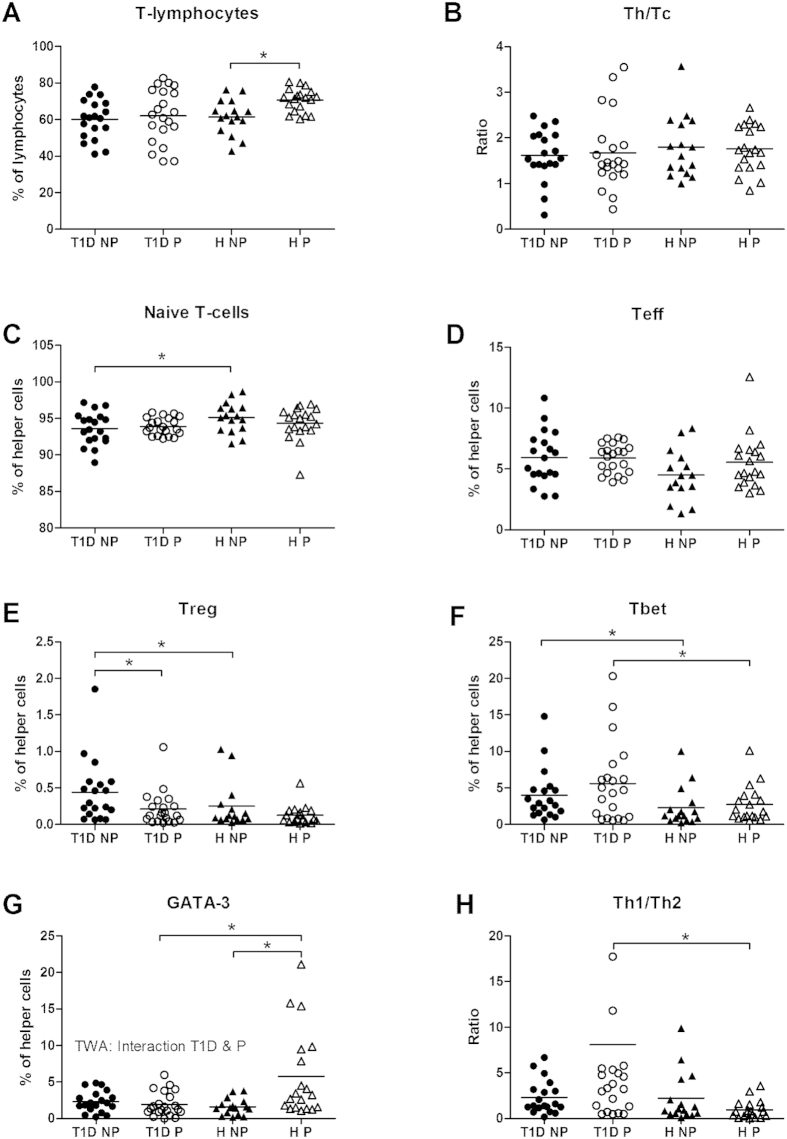
The percentage of T-lymphocytes (A), ratio of helper (Th) and cytotoxic (Tc) T-cells (B), percentage of naive T-cells (C), effector T-cells (D), regulatory T-cells (Treg) (E), Tbet positive Th (as a transcription factor for Th1) (F), GATA-3 positive Th (as a transcription factor for Th2) (G) and the ratio Th1/Th2 (H) in non-pregnant (NP) and pregnant (P) women with type 1 diabetes and healthy women. *Significant difference between the marked groups, independent T-test, p < 0.05. I: Significant interaction between diabetes and pregnancy, p < 0.05, two-way ANOVA.